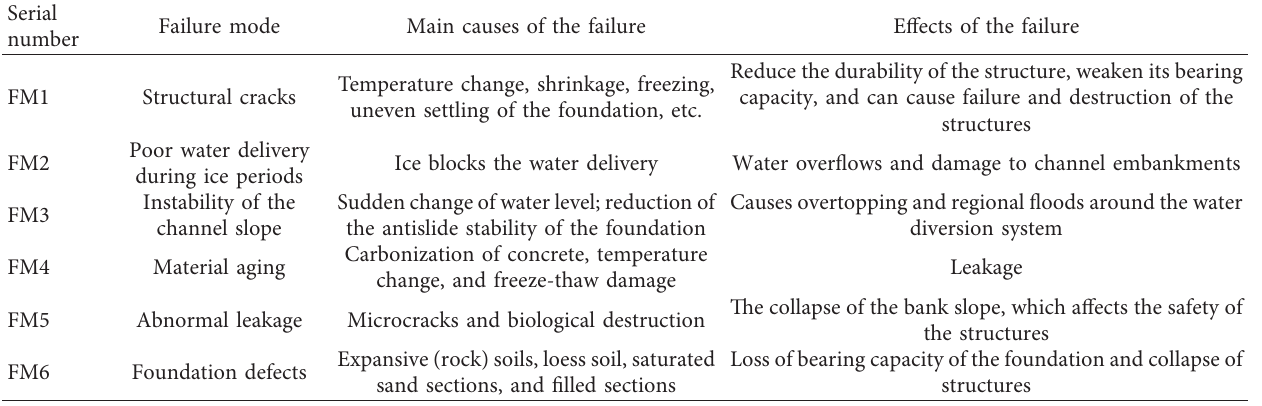
Table 1: The failure modes of the water channels in the MRP during the operation